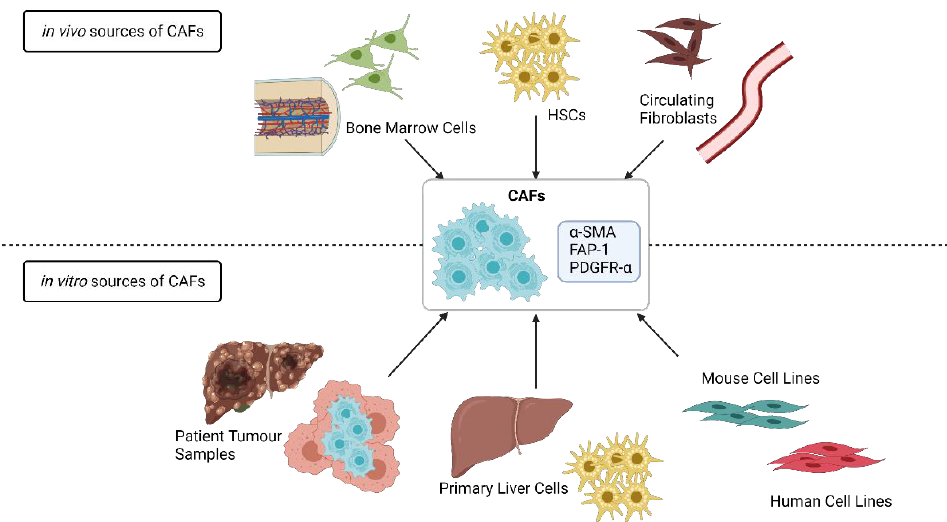
Figure 1. Cellular sources of myofibroblasts or CAFs in liver cancer. CAFs are a heterogeneous group of cells derived from several sources. In the liver, the majority of CAFs are derived from HSCs, but a minor percentage of CAFs originates from Bone Marrow Cells or Circulating Fibroblasts. The most frequently used markers to define CAFs include α -SMA, FAP-1, and PDGFR- α and are shared by the different cellular CAF sources. For in vitro studies, fibroblast or HSC cell lines of mouse or human origin are often used, but some studies use CAFs isolated from Mouse or Patient Tumour Samples or Primary Hepatic Stellate Cells. Image created by Biorender.